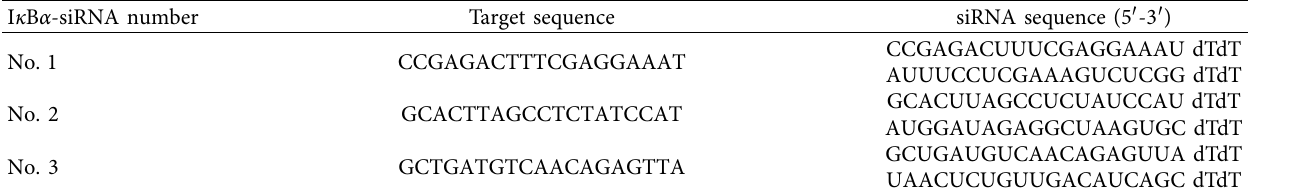
Table 1: Cynomolgus Monkey I κ B α gene siRNA